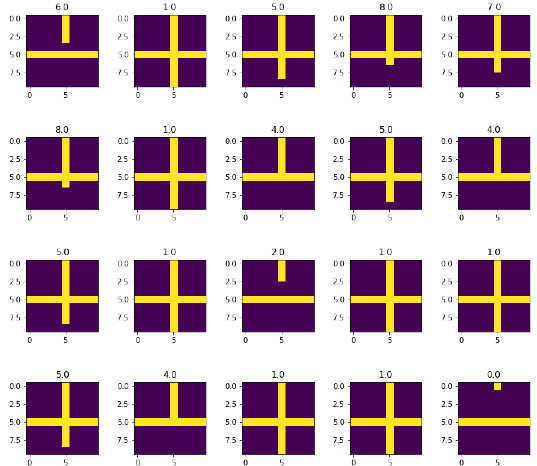
Figure 9. Cluster results of 20 samples, images shown are heterogeneous fields, the number on top of each image is the cluster assignment ID number.